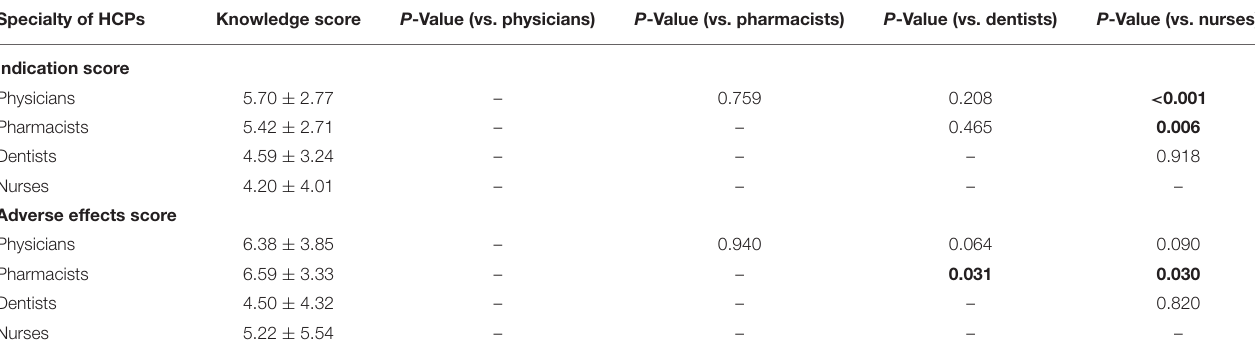
The bold values indicate significant results and their values is less than